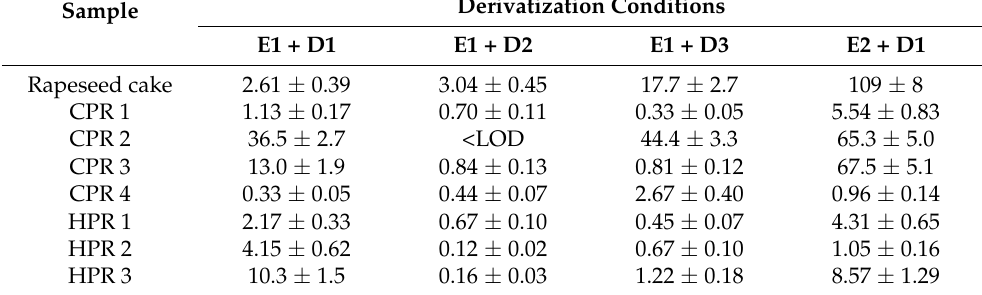
Table 2. Quantity of erucic acid (µg/g of sample) in rapeseed cake and protein products CPR1-4 and HPR 1-3 for different extraction (E) and derivatization (D) methods (E1: Folch method, E2: Soxhlet method; D1: HCl/methanol derivatization, D2: NaOH/BF 3 derivatization, D3: H 2 SO 4 derivatiza-